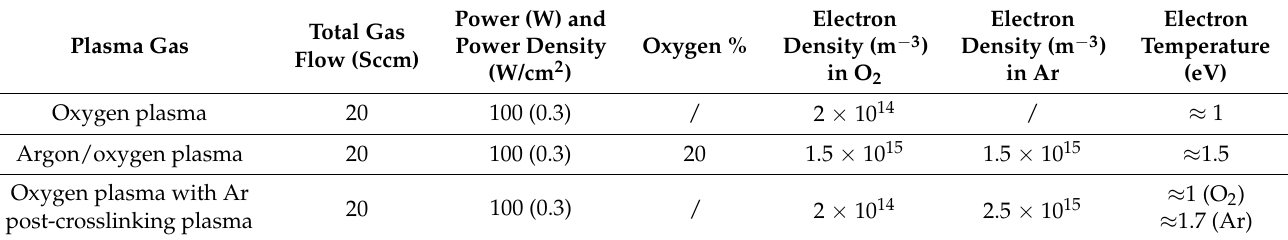
Table 1. Experimental conditions of plasma